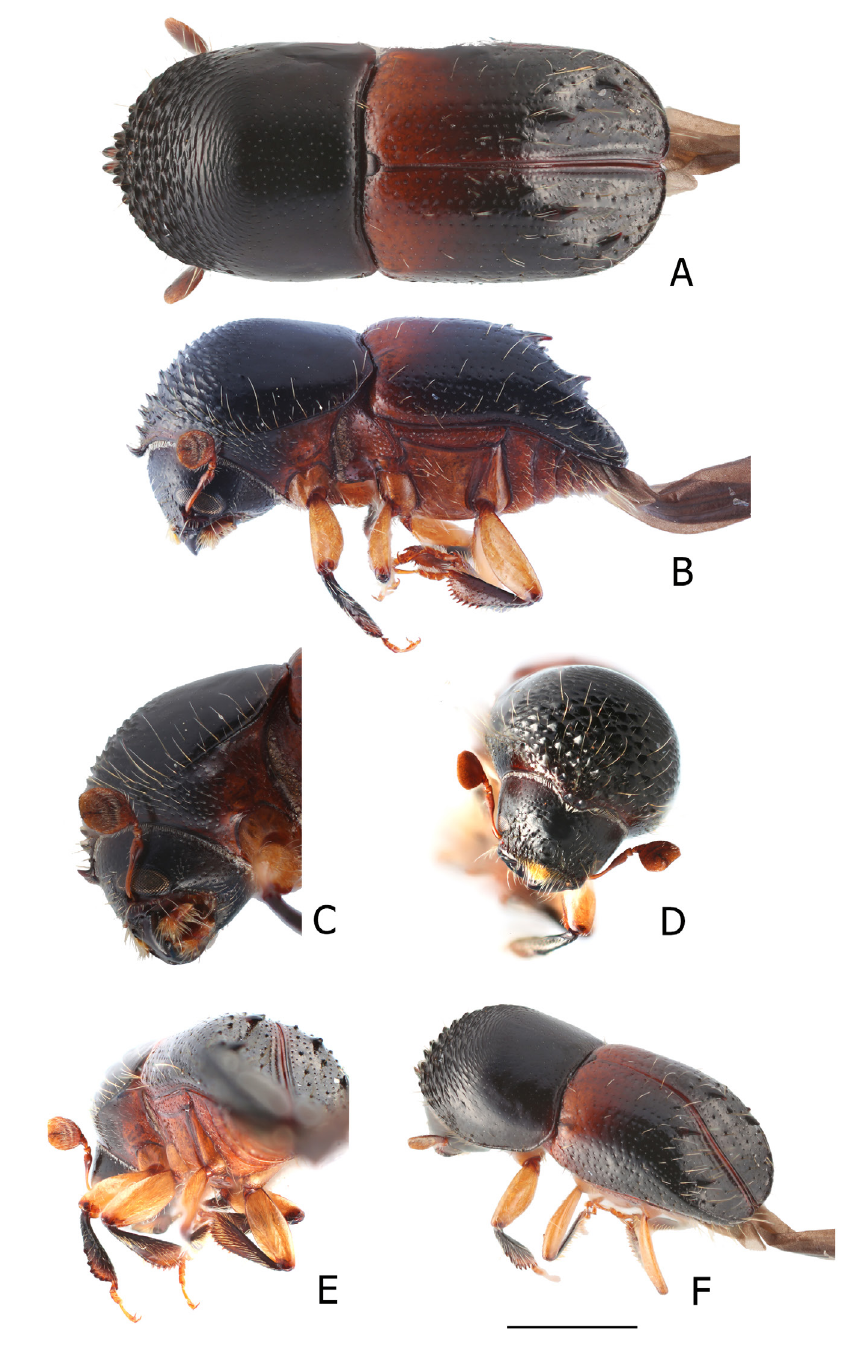
Figure 1 Cnestus quadrispinosus sp. n. A Dorsal view, B Ventro-lateral view, C Antenna, D front, E pro-, meso-, and meta-tibia, F posterolateral view. Scale bar: 2